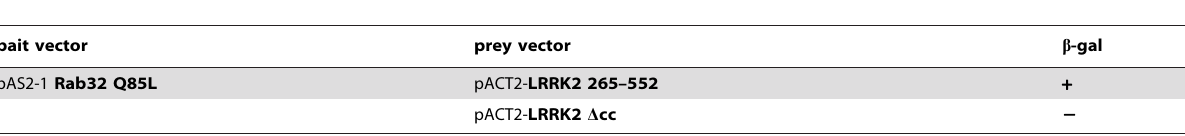
After co-transformation of the yeast strain Y190 with the indicated plasmids with and without the hypothetical coiled-coil motif, cells were grown on synthetic media lacking histidine, supplemented with 30 mM 3 AT. Cell growth on these media and blue staining in subsequent b -gal-filter assays indicated direct interaction of the proteins. no growth on selection media or staining in ß-galactosidase filter assay, + growth on selection media and blue staining in in ß-galactosidase filter assay. n=3 independent experiments.